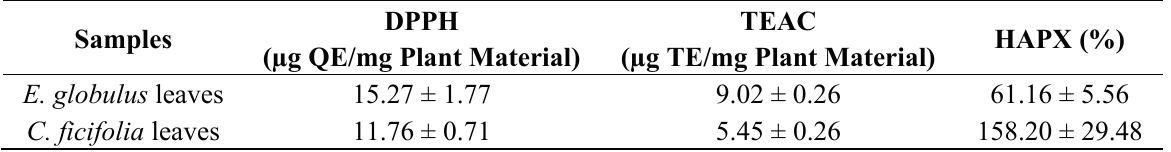
Table 3. Antioxidant capacity parameters obtained using several methods for studied